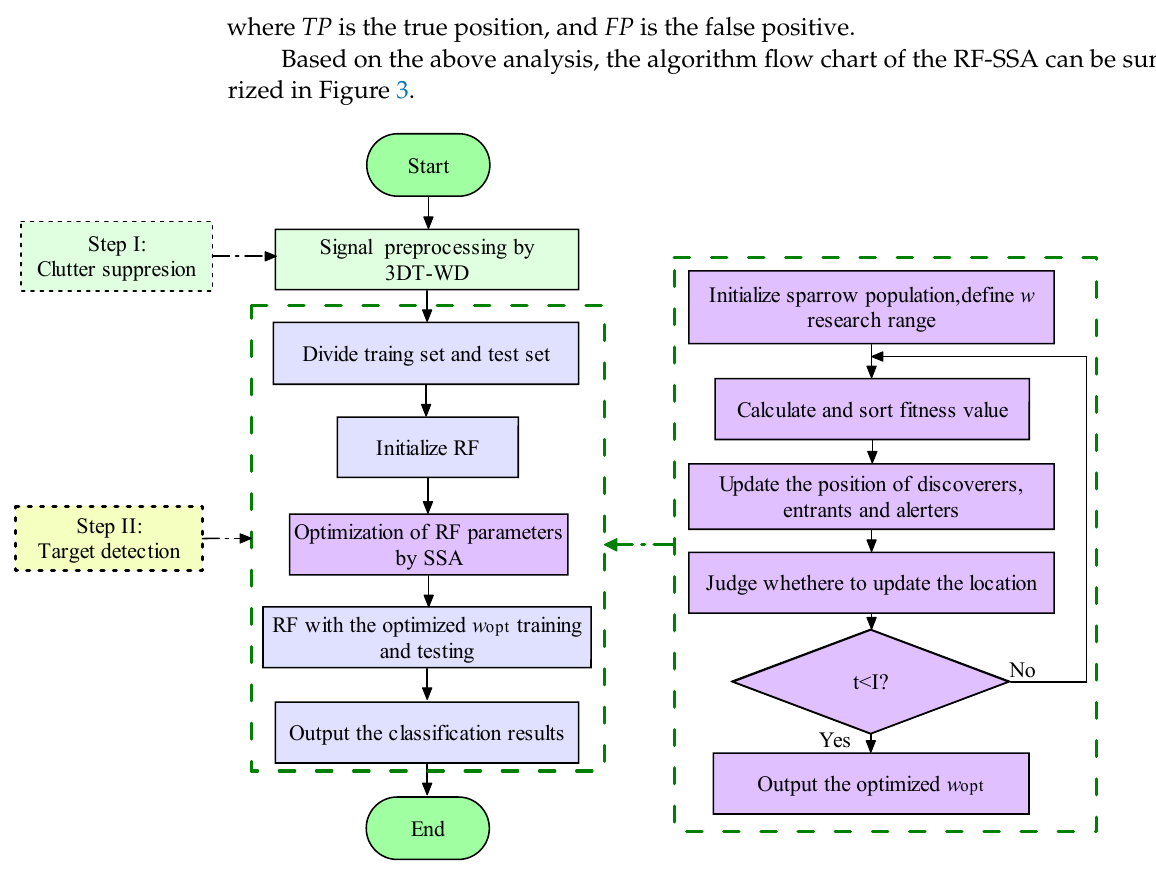
Figure 3. Algorithm flow chart of RF-SSA.